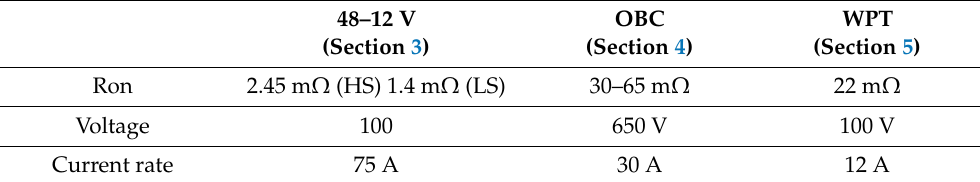
Table 2. Main characteristics of the GaN devices used in Section 3, Section 4, and Section